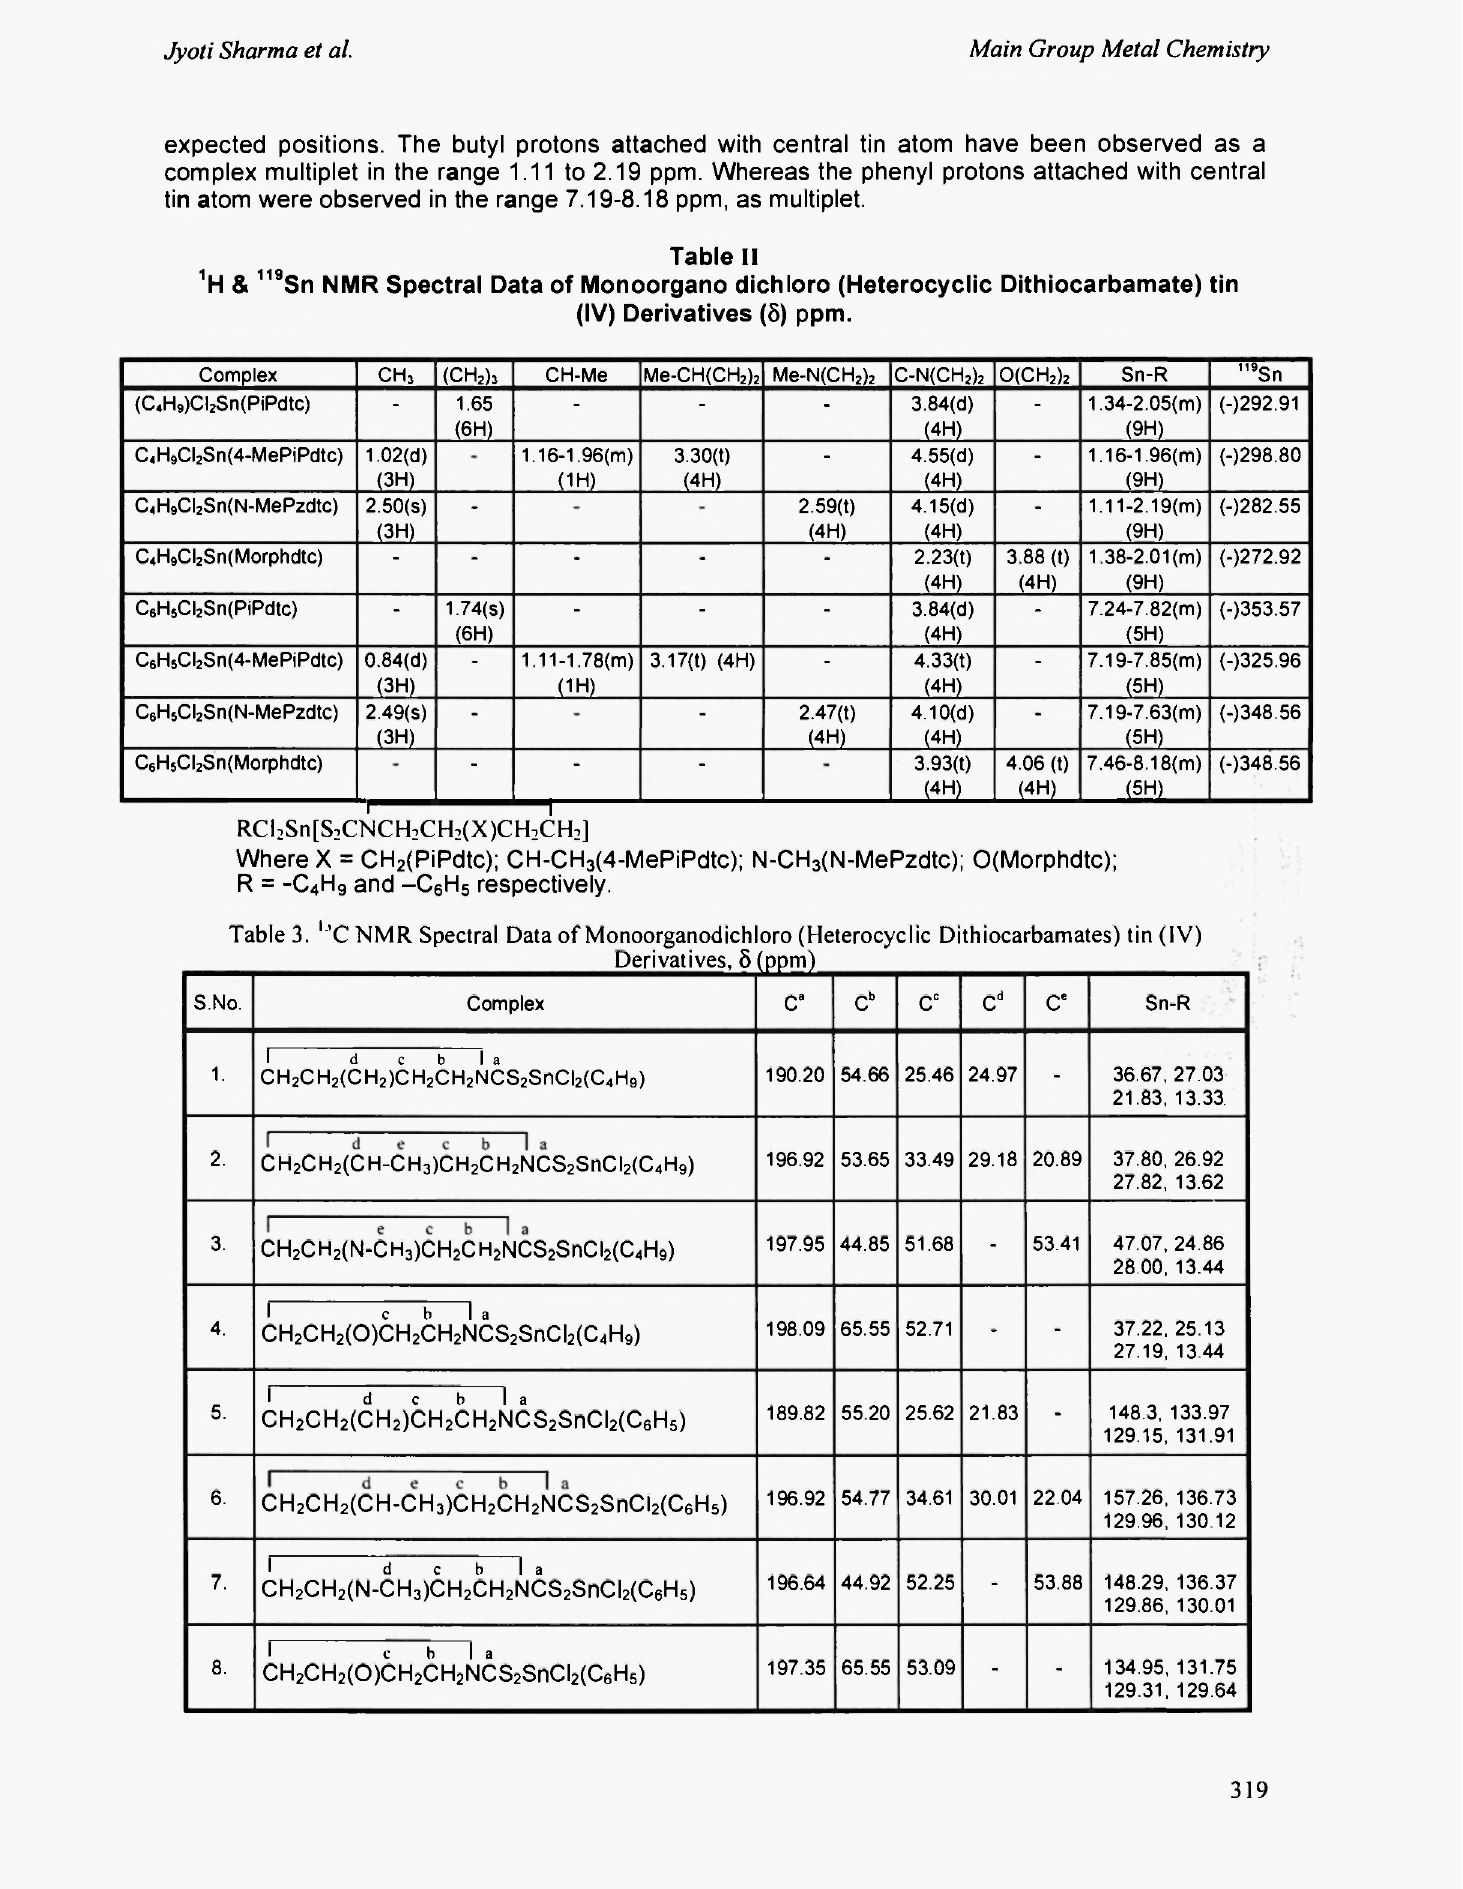
Table II 1 H & 119 Sn NMR Spectral Data of Monoorgano dichloro (Heterocyclic Dithiocarbamate) tin (IV) Derivatives (δ) ppm.